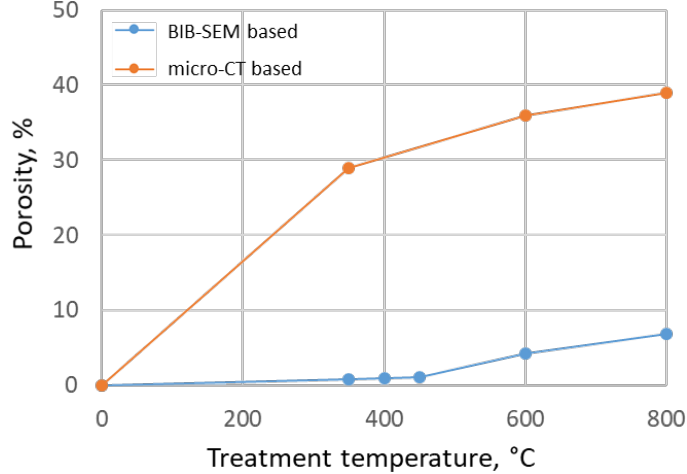
Figure 10. Micro-CT slices in XZ plane of Ch-46t sample before heating and after heating at 400 ◦ C, 600 ◦ C, and 800 ◦ C ( XZ , XY , and YZ planes). Slices for the initial state and at 400 ◦ C and 600 ◦ C were selected for the same areas. Arrows indicate fractures.